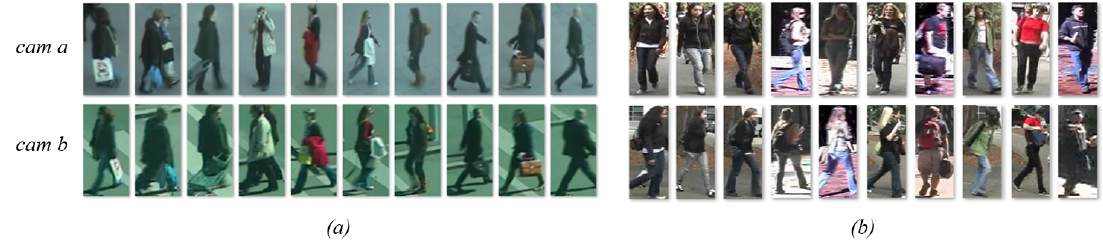
Figure 4. Examples of matched pairs belonging to PRID2011 ( a ), and VIPeR dataset ( b